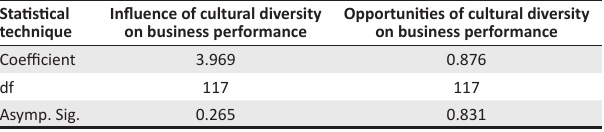
TABLE 2: A t -test on the influence of cultural diversity on business